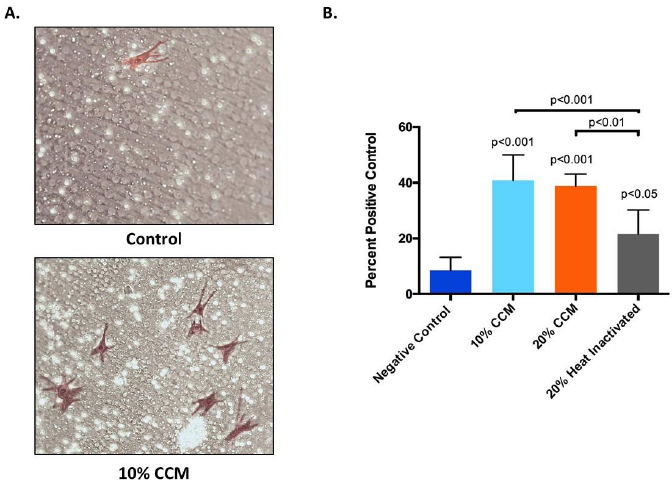
Figure 4. ( A ) Representative, typical images (20X) of migrated Bone marrow mesenchymal stem cells (BMSCs) on the bottom of the Transwell insert after 24 h suspension in negative control (media only) and 10% CCM. ( B ) Cell migration of BMSCs suspended in media only (negative control), 10% and 20% CCM, and heat inactivated (neutralized) 20% CCM for 24 h. Data represents mean ± SEM with significant difference between negative control versus CCM groups ( p < 0.001) and heat inactivated CCM ( p < 0.05); and significant reduction in inducing BMSCs migration of the heat inactivated CCM relative to the 10% CCM ( p < 0.01) and 20% CCM ( p < 0.001). CCM was produced in two lots in duplicate from two vials and cell migration assay was performed using CCM from each lot three separate times in